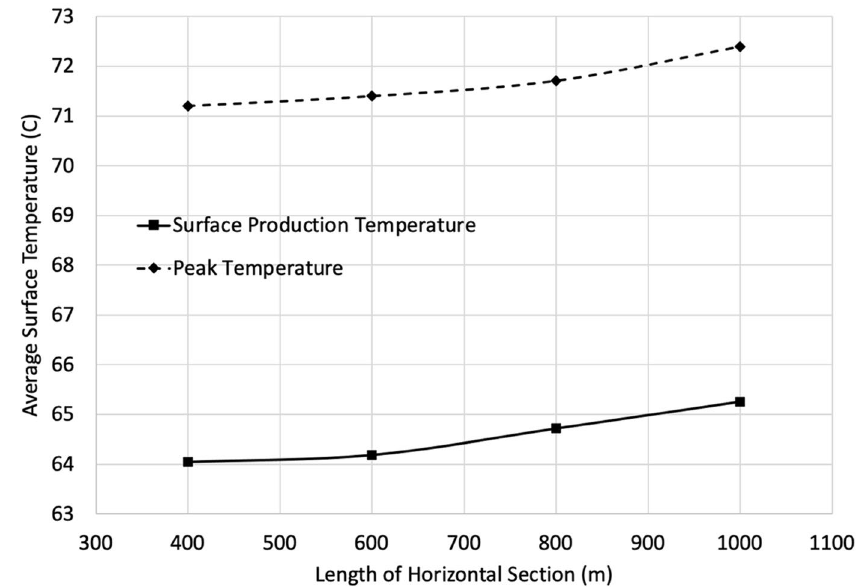
Fig. 9 Effect of length of horizontal section on the peak temperature and produced fluid temperature (temperature values are the average of the last 20 years for case of 200 m 3 /day working fluid flow